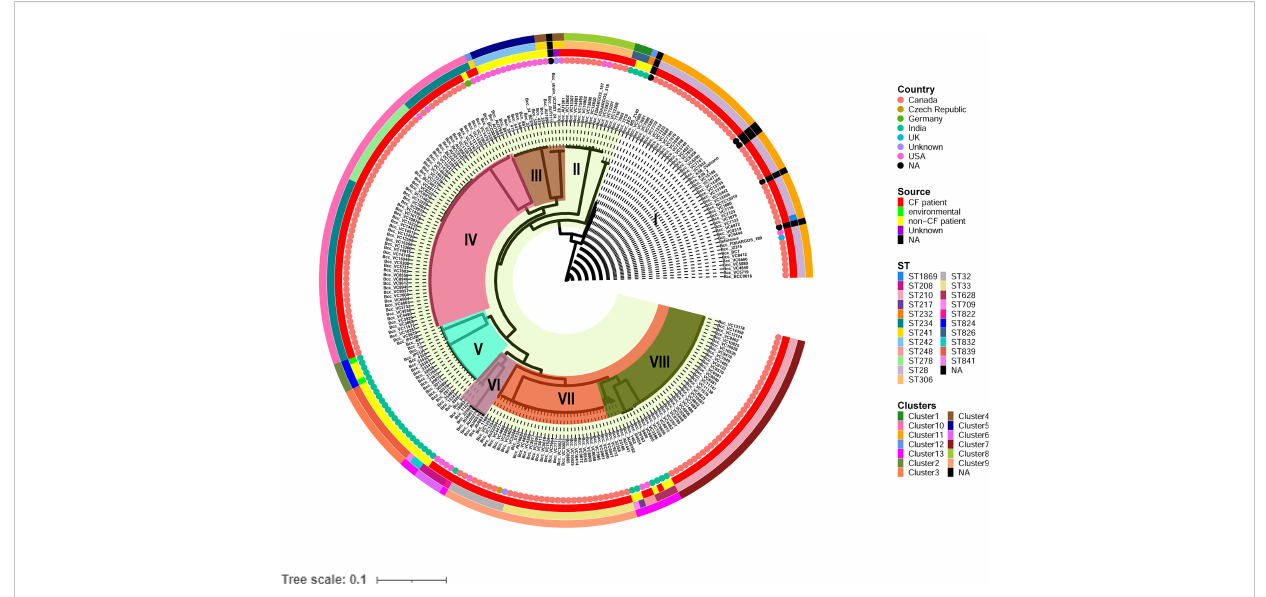
FIGURE 1 Phylogenetic structure of 245 CC31 isolates. Clades I-VIII are marked by background colour fi ll. Data on the country of isolation, source of isolation, MLST classi fi cation, and fastbaps clusters are depicted on the tree (from inner to outer